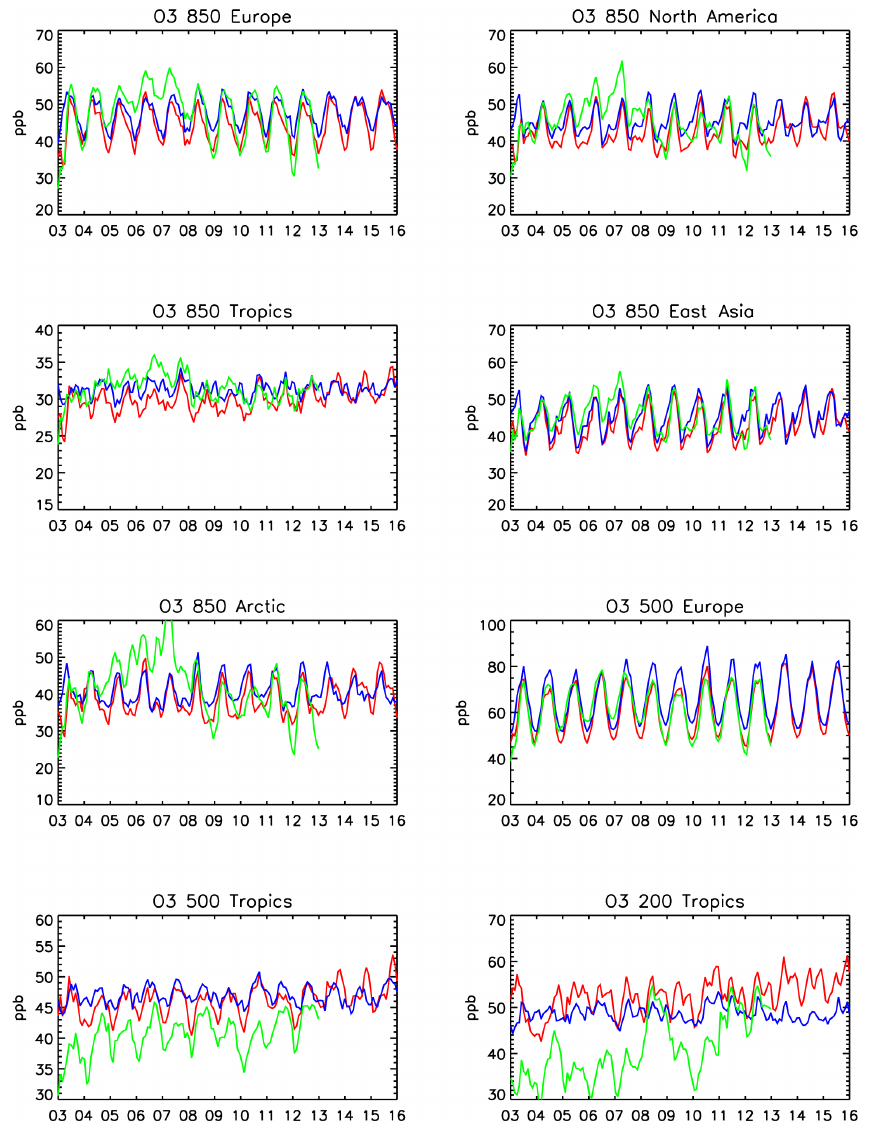
Figure 21. Monthly ozone volume mixing ratios at 850, 500 and 200hPa over different regions (see Table 3) from CAMSiRA (red), the CR (blue) and MACCRA (green) for